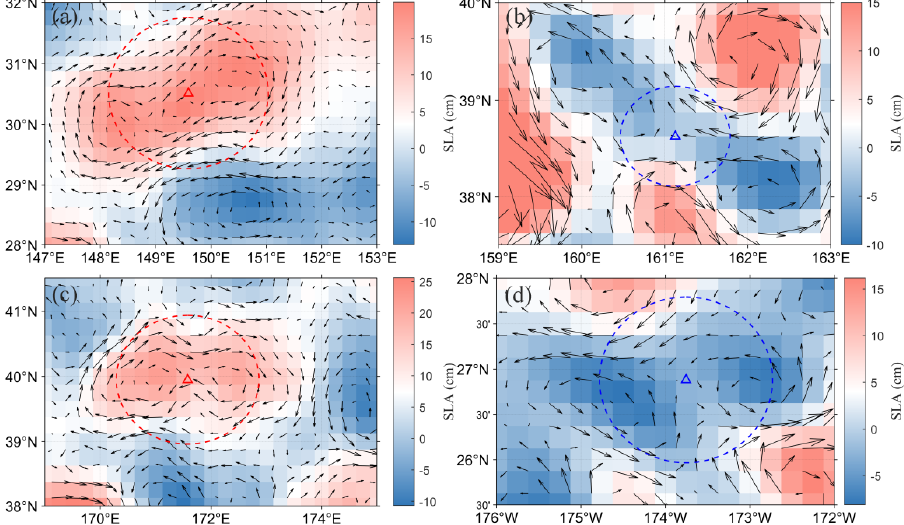
Figure 20. Four cases of the close of two eddies. Red (blue) curves represent AEs (CEs). ( a ) 14 February 2019, in KE region, ( b ) 14 March 2019, in KE region, ( c ) 6 March 2019, in KE region, and ( d ) 17 April 2019, in SF region.